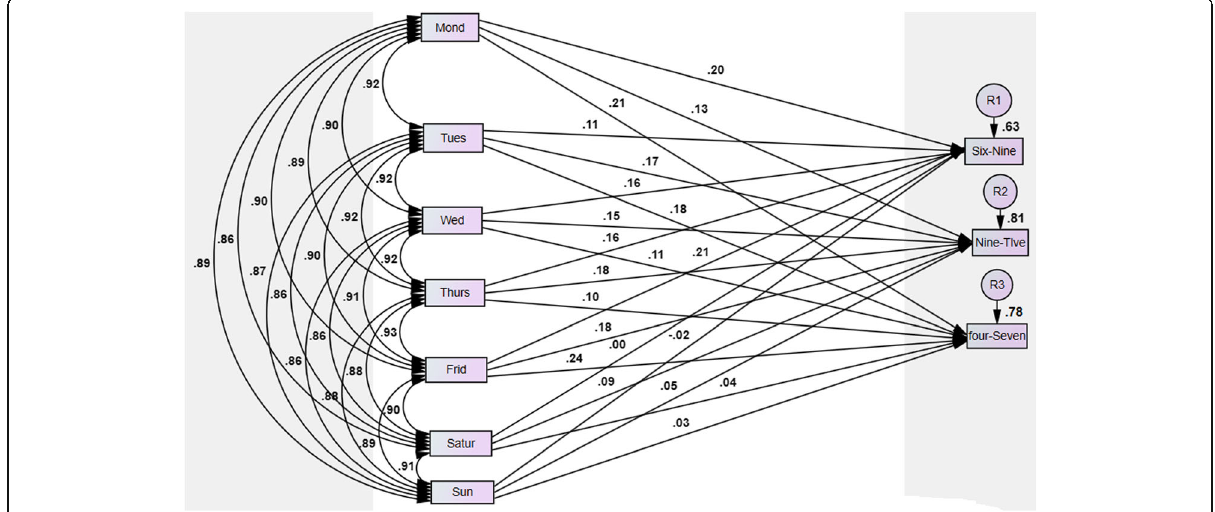
Fig. 3 The relationship between weekdays, weekends and peak and off-peak hours (private cars and taxis